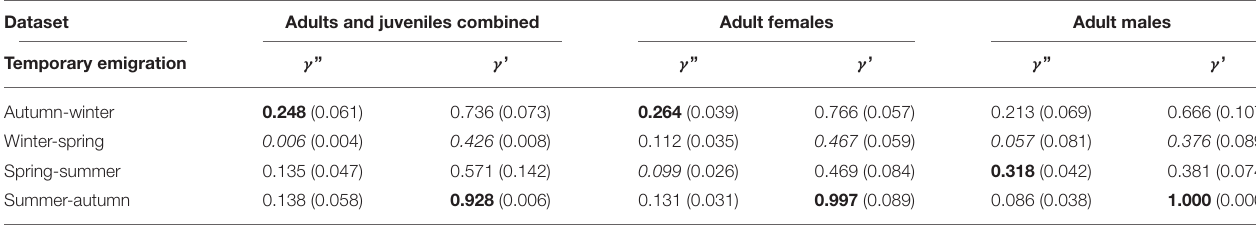
TABLE 4 | Temporary emigration for three datasets: adults and juveniles combined (mean of time varying values), adult females, and adult males.